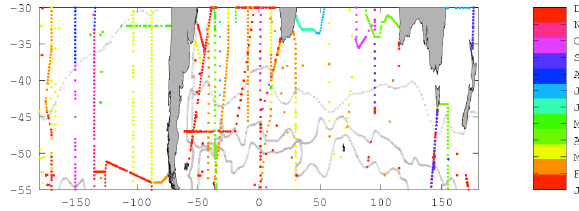
Fig. A3. Distribution and sampling month of DIC used to derive the 3-D-gridded Glodap product in the Southern